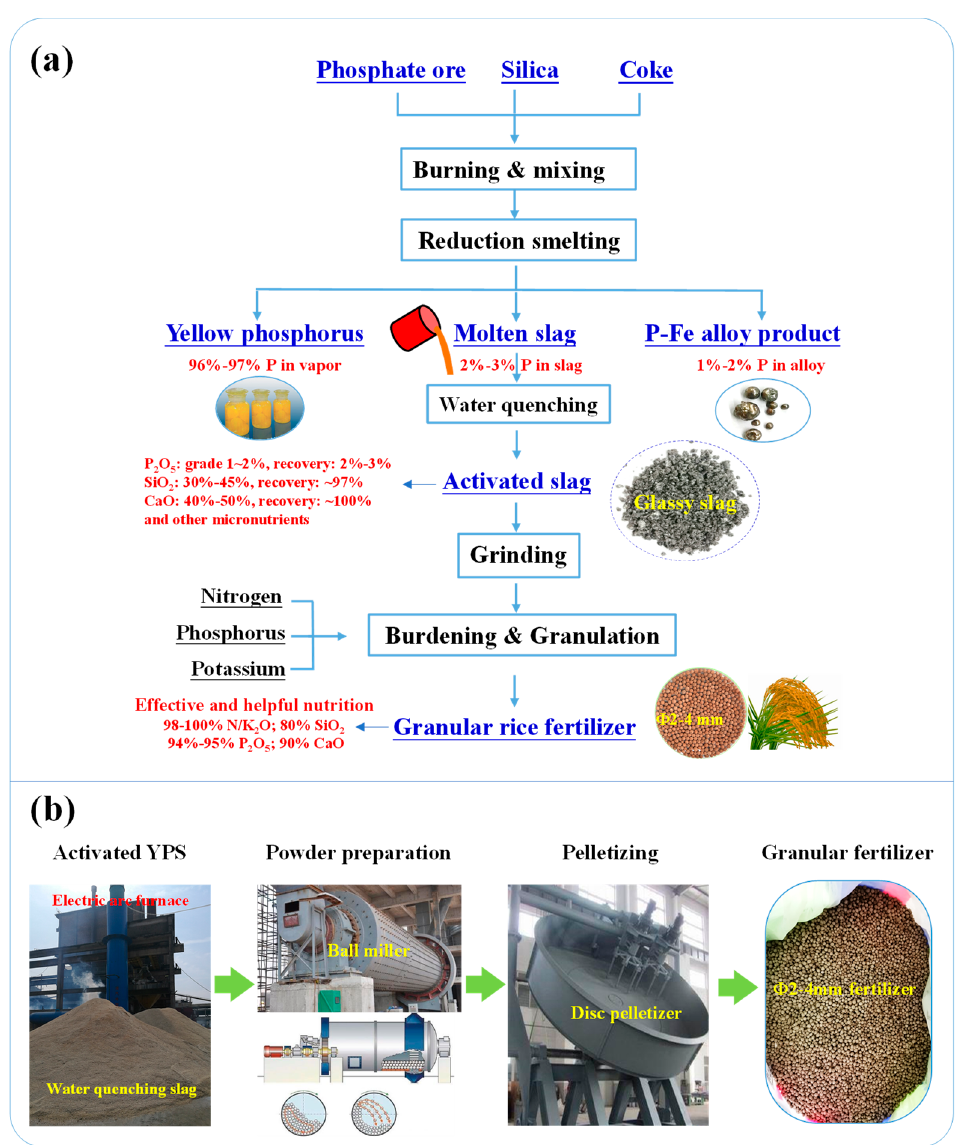
Figure 11. ( a ) Flowsheet and elements distribution in the treatment of phosphorite; ( b ) Possible and recommended industrial equipment for the granular fertilizer preparation from activated YPS in the existing yellow phosphorus smelting factory.